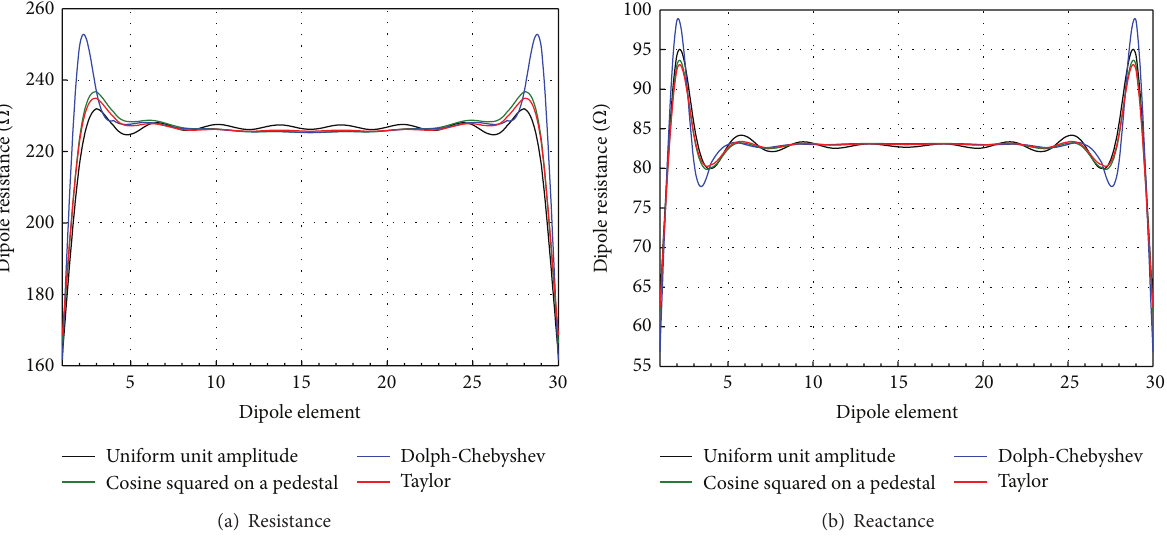
of the dipole elements in collinear configuration . 𝑛